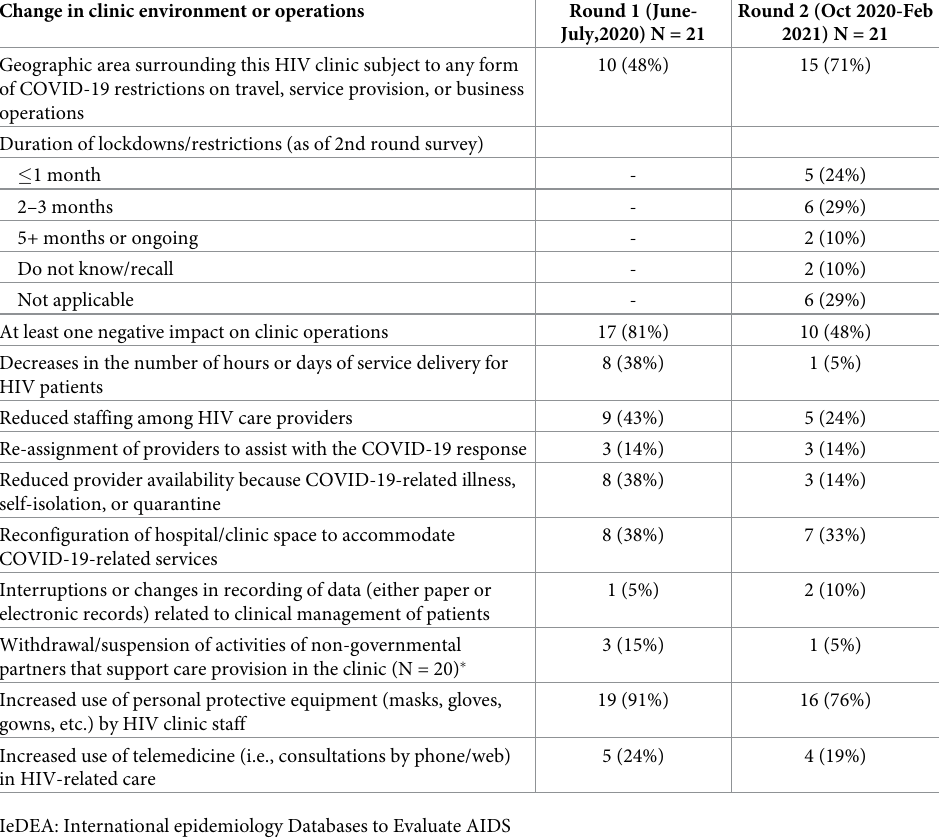
Table 2. COVID-19 pandemic-related changes in clinic environment or operations at Central Africa IeDEA sites, 2020–2021. Change in clinic environment or